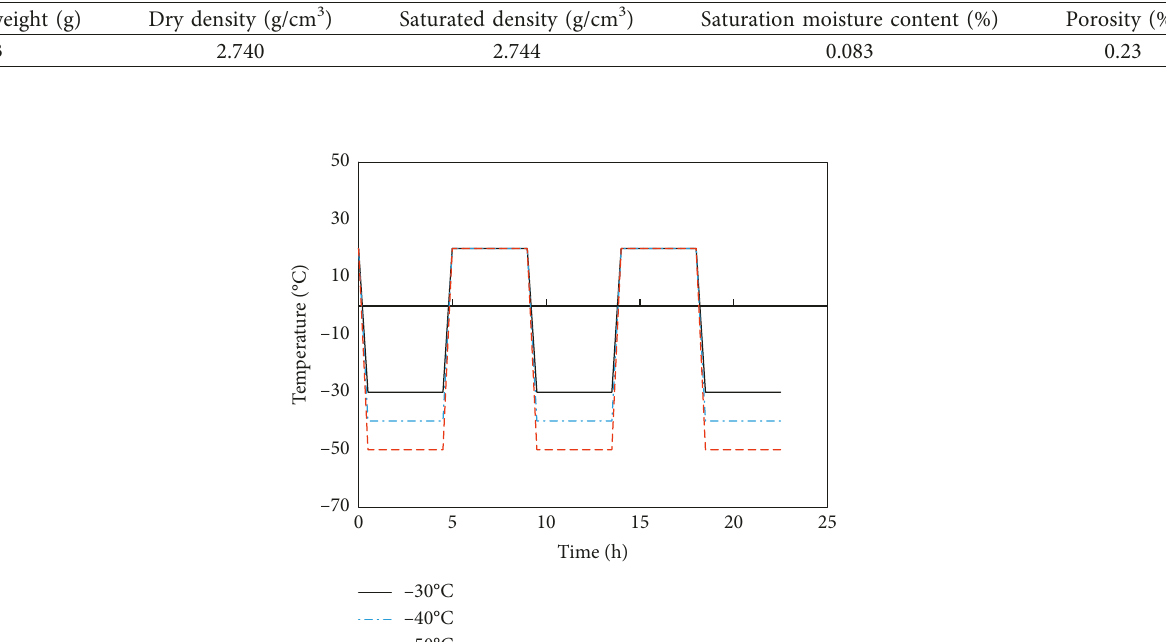
Table 1: Original properties of tonalite.